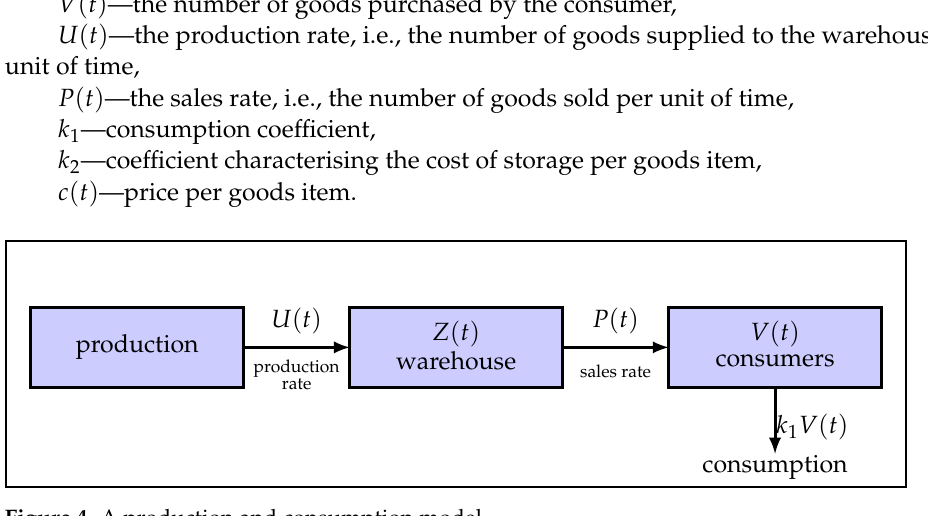
Figure 4. A production and consumption